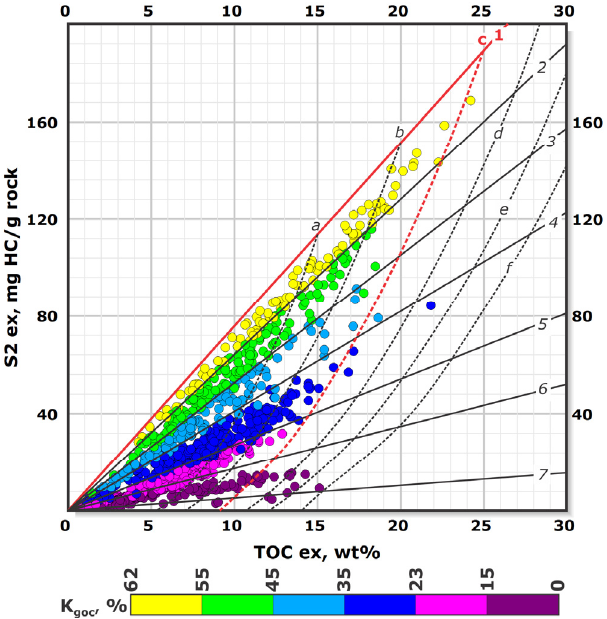
Figure 4. S2 ex -TOC ex diagram for the studied sample collection. The color indicates the proportion of generative kerogen K goc . The calculated maturity trends are drawn as solid and dashed lines. Straight solid lines reflect different values of kerogen conversion GOC/TOC 0 : 1—65%; 2—55%; 3—45%; 4—35%; 5—25%; 6—15%, 7—5%. Dashed curves reflect maturity trends for the samples with initial values of TOC 0 equal to a —15, b —20, c —25, d —30, e —35, f —40 wt.%.